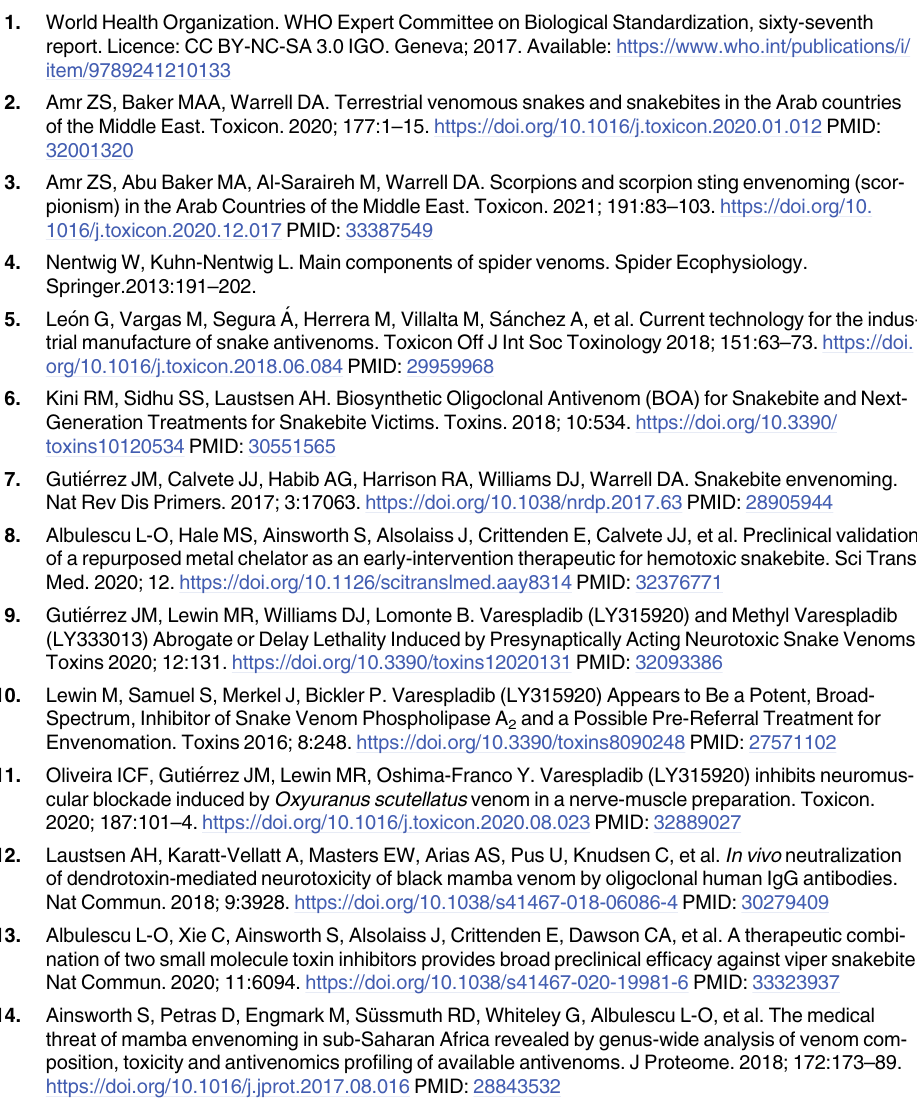
covering the epidemiology of the entire country (dark green). Relevant publications are included in brackets. MENA, Middle East and North Africa. S2 Table. Overview of epidemiological studies included in this review. Parameters assessed included study design, country that the study was conducted in, the study period, how many patients were included ( N ), the respective patient age groups, and what venomous taxa were responsible for the envenomings. It also states whether the articles contained information on the demographics, locality, season/time, species, anatomical site of bite/sting, symptoms, and